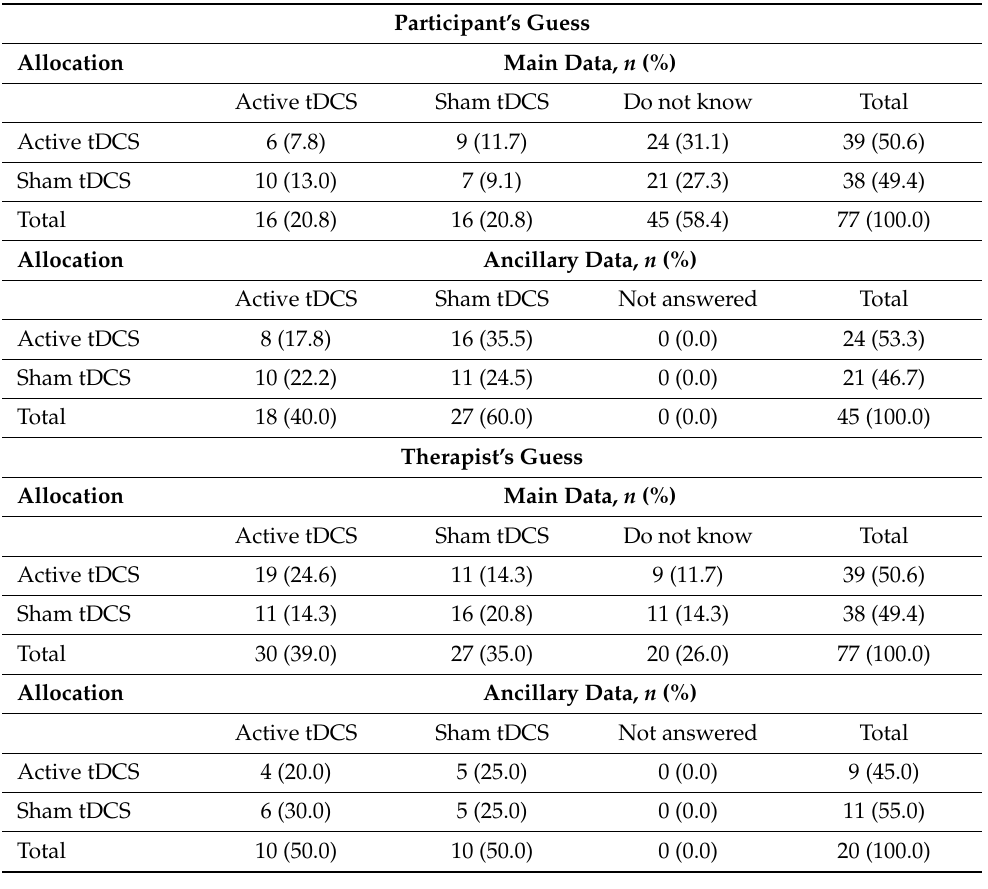
Table 2. Guesses of the participants and the therapist, and ancillary data for ‘Do not know’ responses.